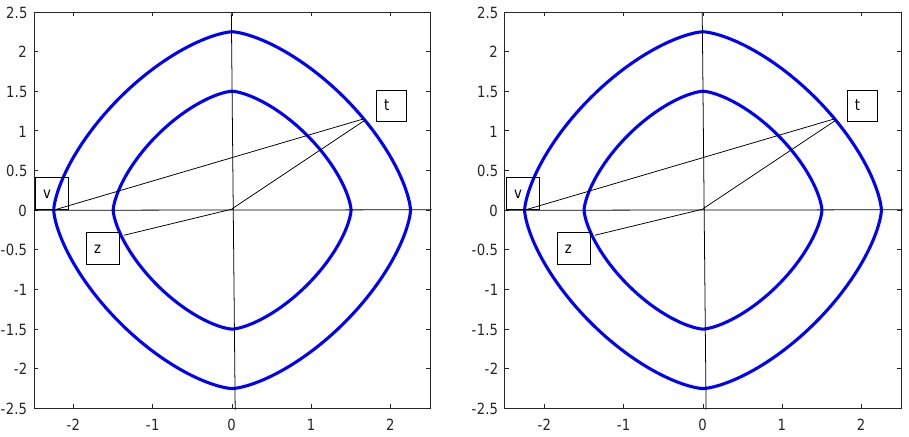
√ n = 1.5 and n = 2.25, similar figures can be